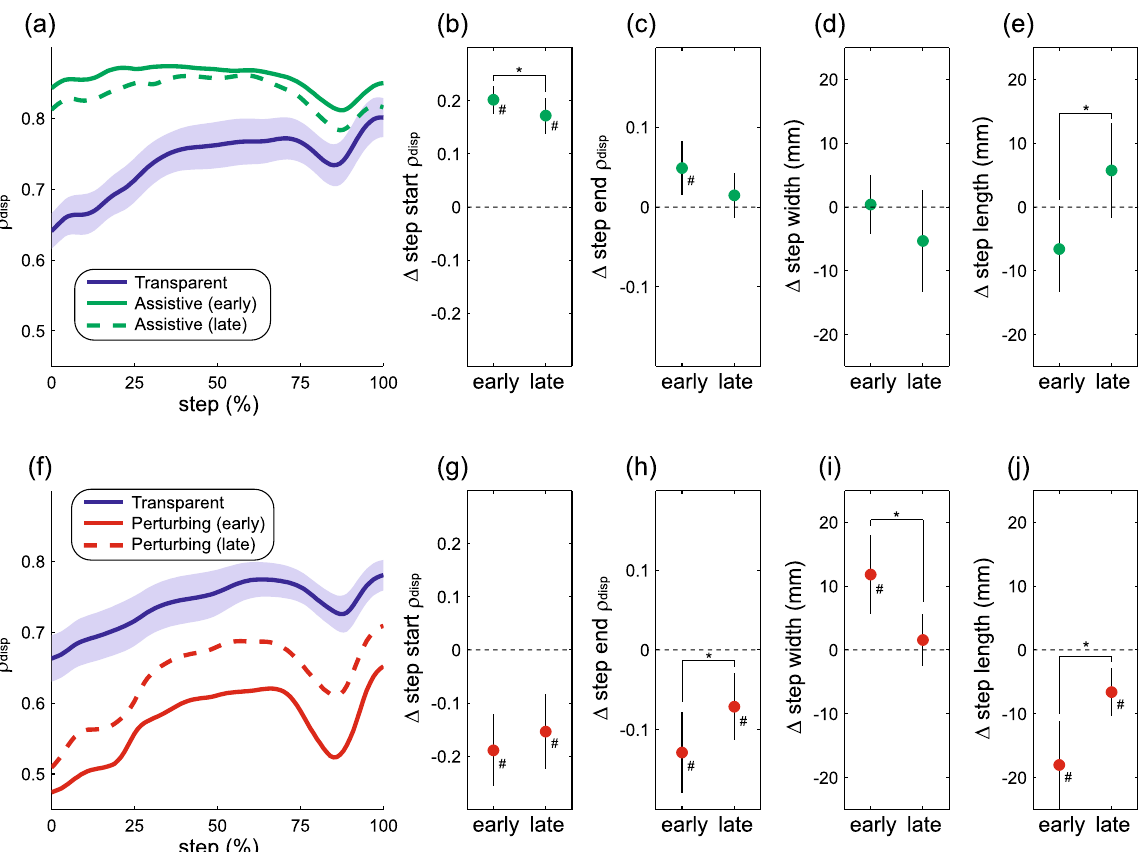
Figure 4. Direct effects of the first force-field exposure. The top row illustrates the direct effects of force-field assistance, in terms of the magnitude of the partial correlation between pelvis displacement and step width (ρ disp ) throughout the step ( a ) and our four gait outcome measures ( b – e ). The bottom row ( f – j ) follows the same structure to illustrate the direct effects of force-field perturbations. For all comparisons, “early” refers to the first 45 steps, while “late” refers to steps 181–225. In panels ( a ) and ( f ), the shaded area indicates the 95% confidence interval for the initial Transparent trial, while confidence intervals are not shown for the experimental conditions to avoid extensive overlap. For the remaining panels, data are presented as the difference from the initial Transparent trial. Data points indicate means and error bars indicate 95% confidence intervals. Asterisks (*) indicate a significant difference between the indicated early and late periods. Pound signs (#) indicate a significant difference from the initial Transparent trial, with the 95% confidence interval not including zero (dashed